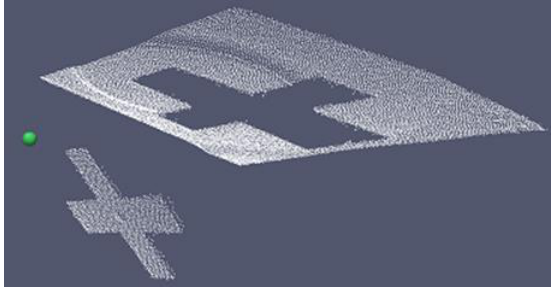
Figure 8. Control point in green for the calibration transform error computation.